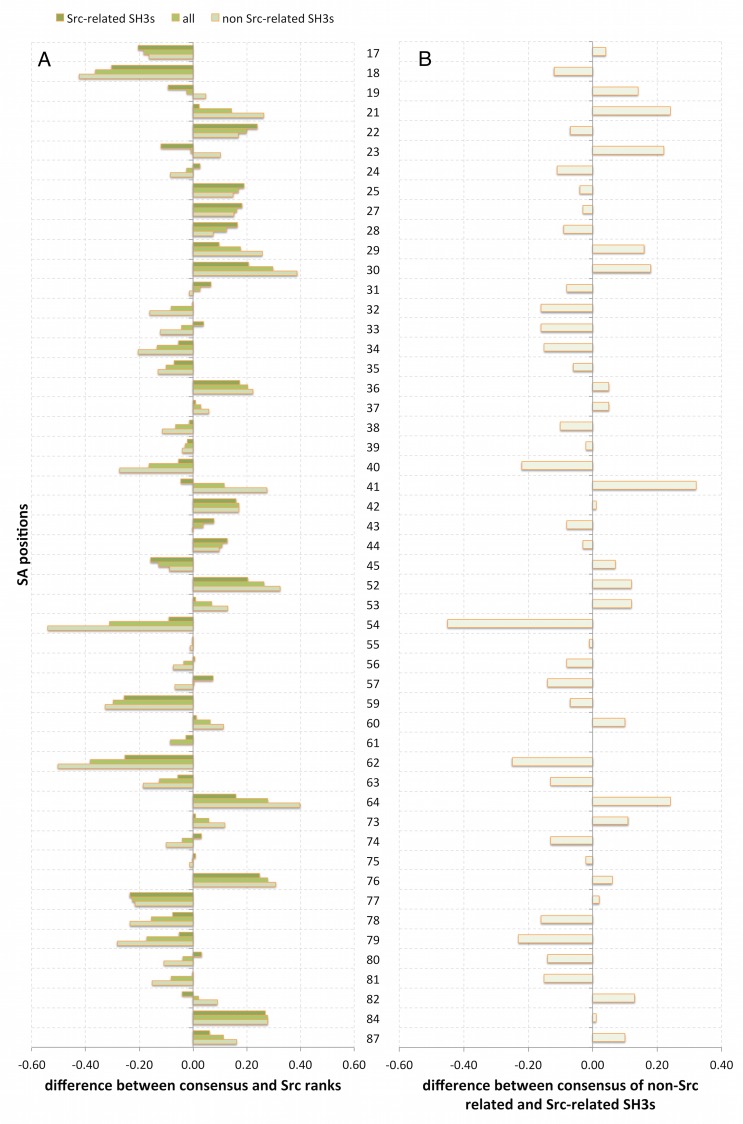
Differences between individual predictions and consensus models.A) Shows the difference in rank between the different consensus models and those obtained for Src SH3 alone. The shading in this bar diagram correlates with the distance from Src (i.e. the lighter the bar the further from Src). B) highlights the ranking differences between the consensus model for the four non-Src-like SH3 domains and the consensus model for the four Src-like SH3 domains. Ranks listed in Table 1 were normalized between 0 and 1, resulting in maximum differences between -1 and 1 in this figure.